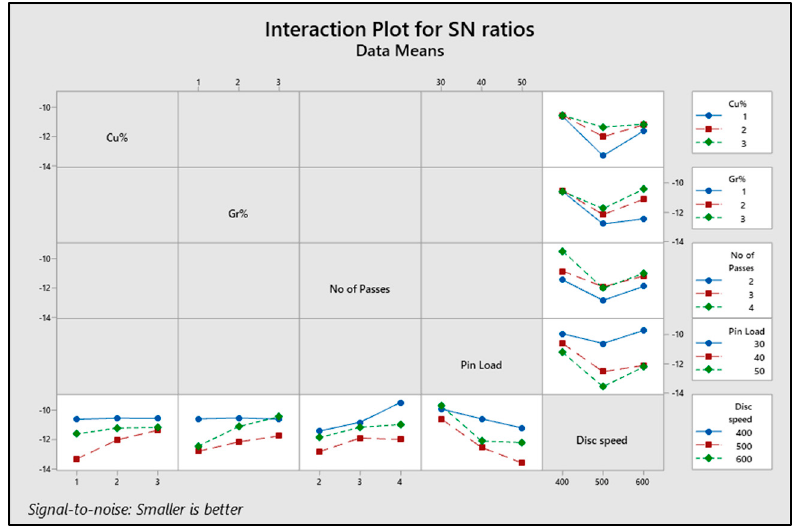
Figure 8. Interaction plot for the SN ratios of wear rate for varying parameters (Cu%, Gr%, No of passes, pin load, disc speed).